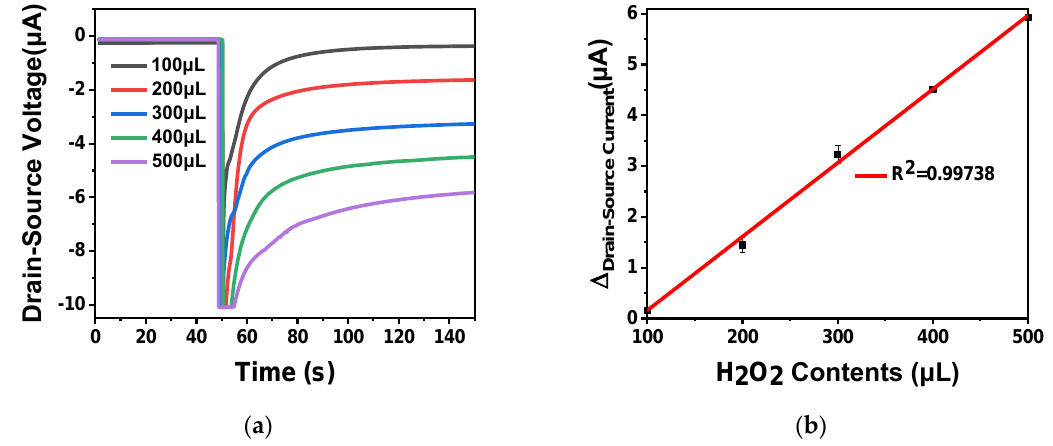
Figure 12. In 2 O 3 nanobelt ISFET hydrogen peroxide detection: ( a ) the reaction curve of hydrogen peroxide and horseradish peroxidase, respectively add 100, 200, 300, 400 and 500 μL of 0.1 mol L − 1 hydrogen peroxide and immobilized horseradish peroxidase in 0.01 × PBS environment; ( b ) linear curve of the difference between the drain – source current of the reaction of hydrogen peroxide and horseradish peroxidase.